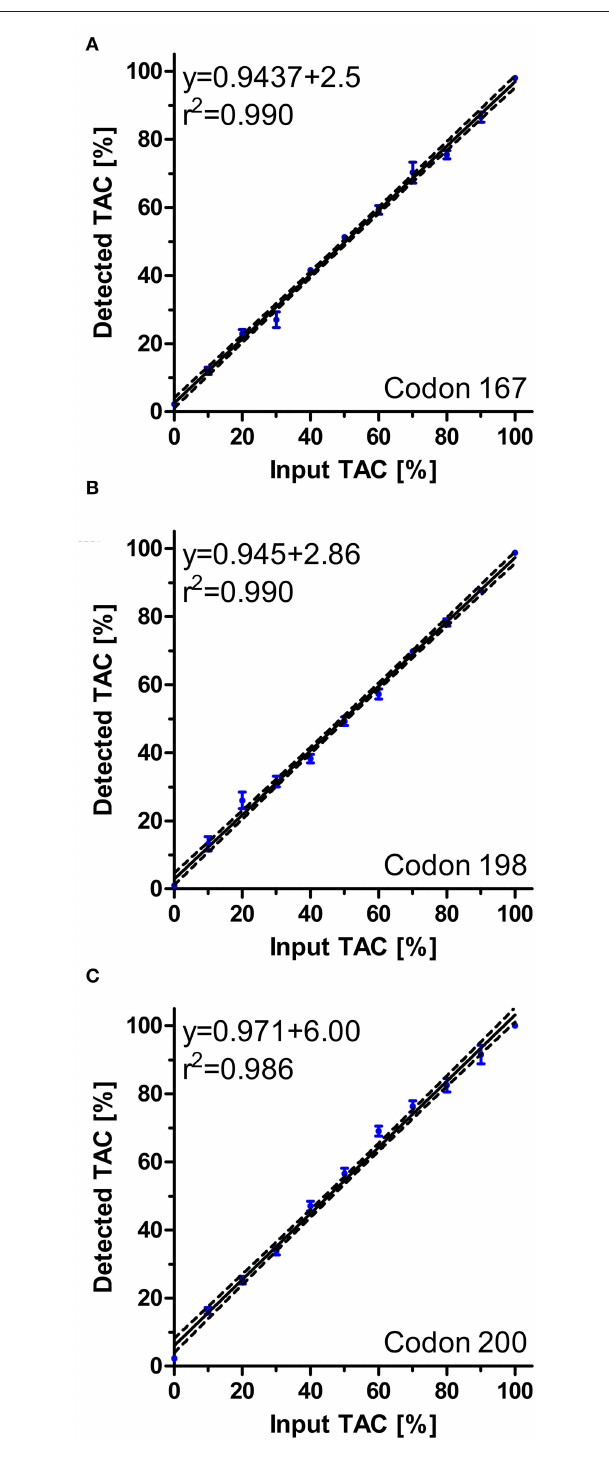
FIGURE 5 | Regression analysis of pyrosequencing assays for S. vulgaris isotype 1 β -tubulin for polymorphisms F167Y (A) , E198A (B) and F200Y (C) . Artificial mixtures of plasmids were prepared and analysed using pyrosequencing. For each mixture, four to six replicates were used and included in the analyses. Regression plots with 95% confidence bands as calculated by Pearson regression are shown. Raw data are shown as circles (dots) ±